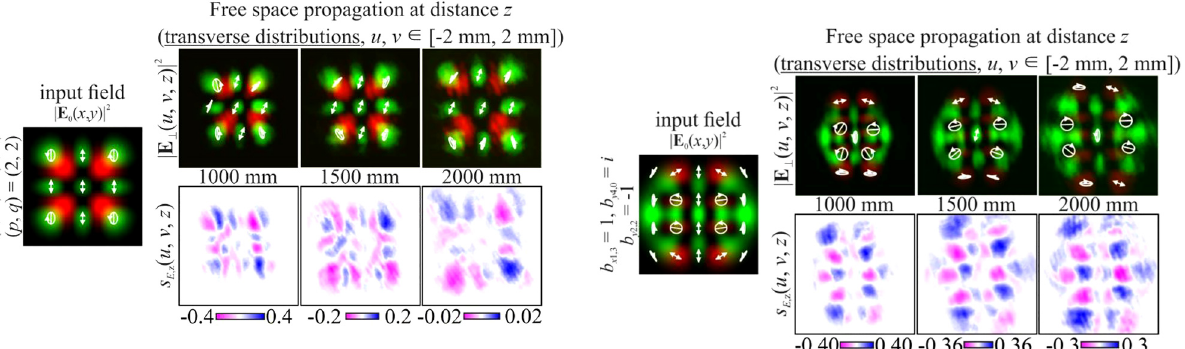
Figure 15: Experimental results for an inhomogeneously polarized multimode HG beam defined by Eq. (11) with indices satisfying the condition de fi ned by Eq. (12) (a nonuniformly polarized vector